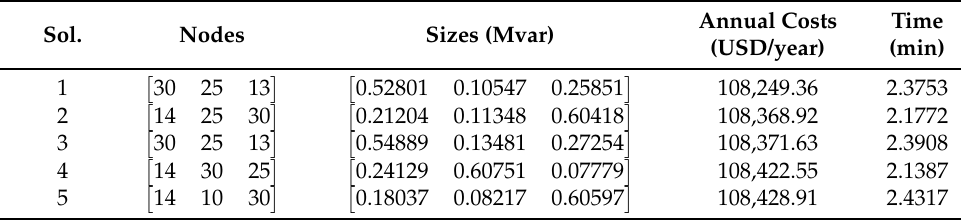
Table 4. Best five solutions found by the proposed solution methodology for the radial operation case.